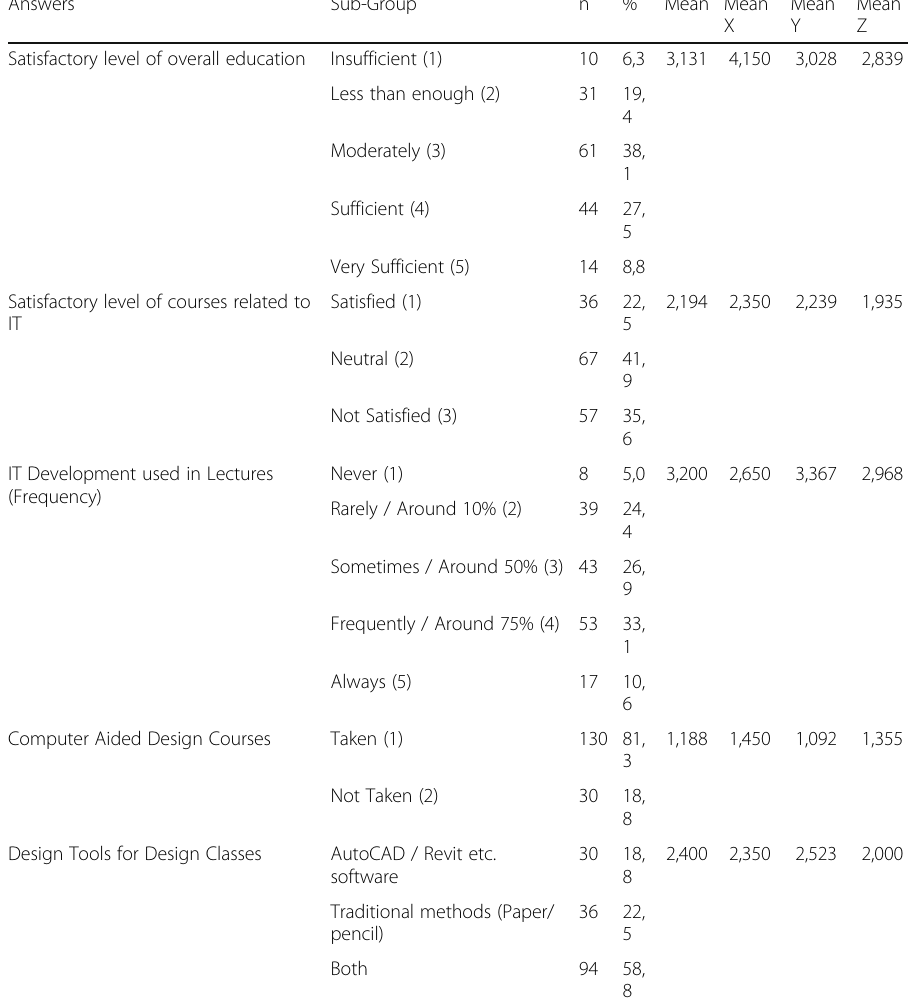
Table 3 Answers of Respondents According to Generations Answers Sub-Group n % Mean Mean